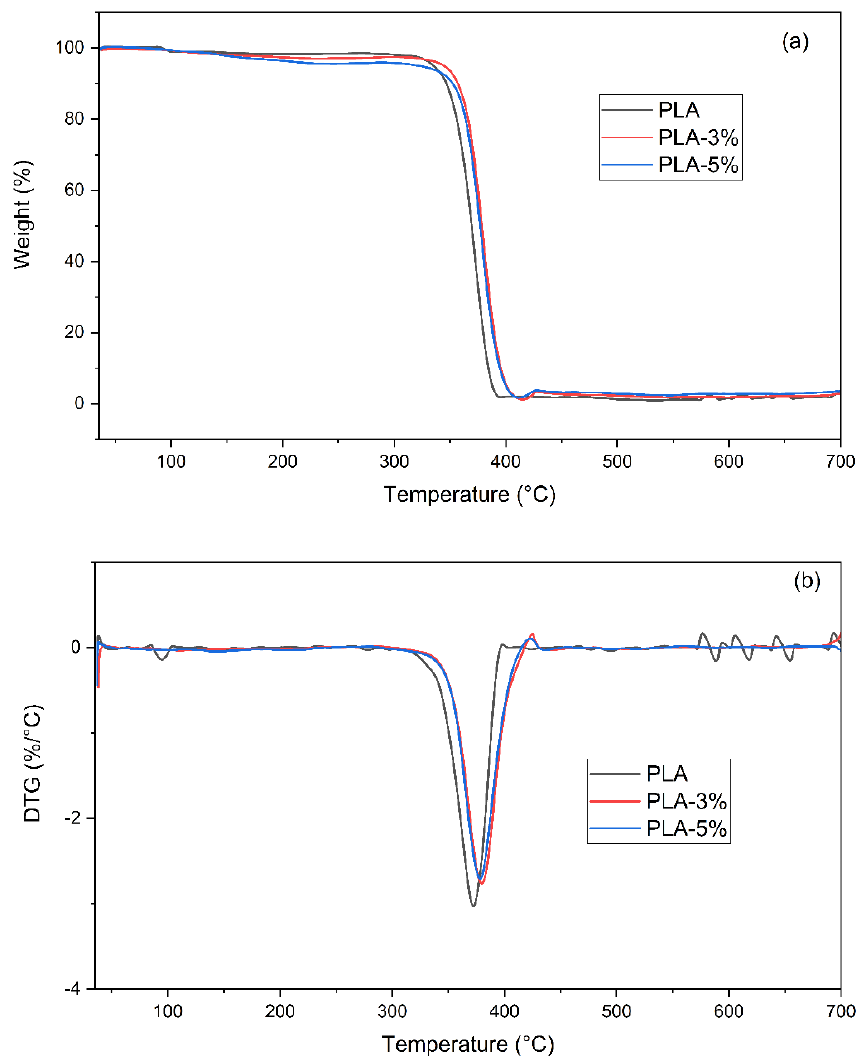
Figure 4. ( a ) TGA and ( b ) DTG of PLA, PLA-3%, and PLA-5% CaCO 3 fillers.